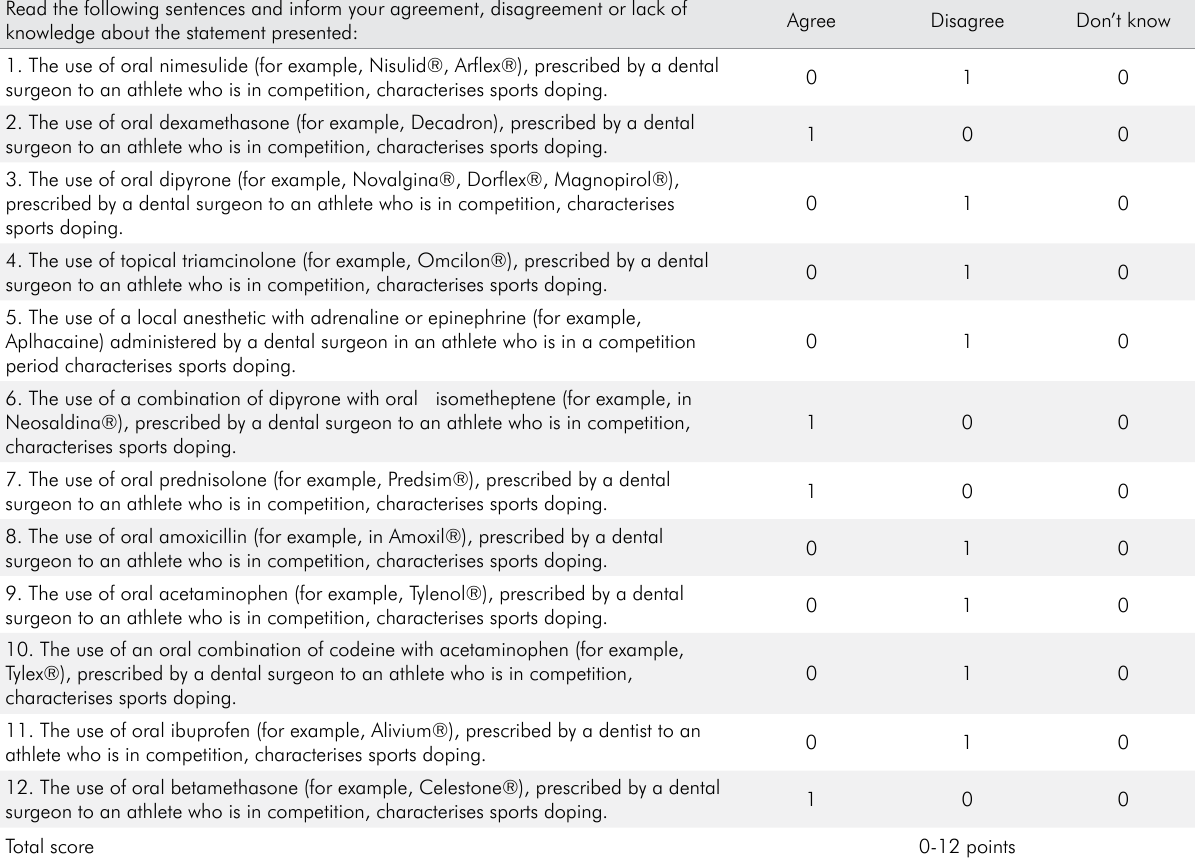
Table 5. English version (not validated) suggested for the Brazilian Knowledge Scale about Sports Doping in Dentistry (B-KSSDD) and scores added to the total score according to the participants’ responses. Read the following sentences and inform your agreement, disagreement or lack of knowledge about the statement